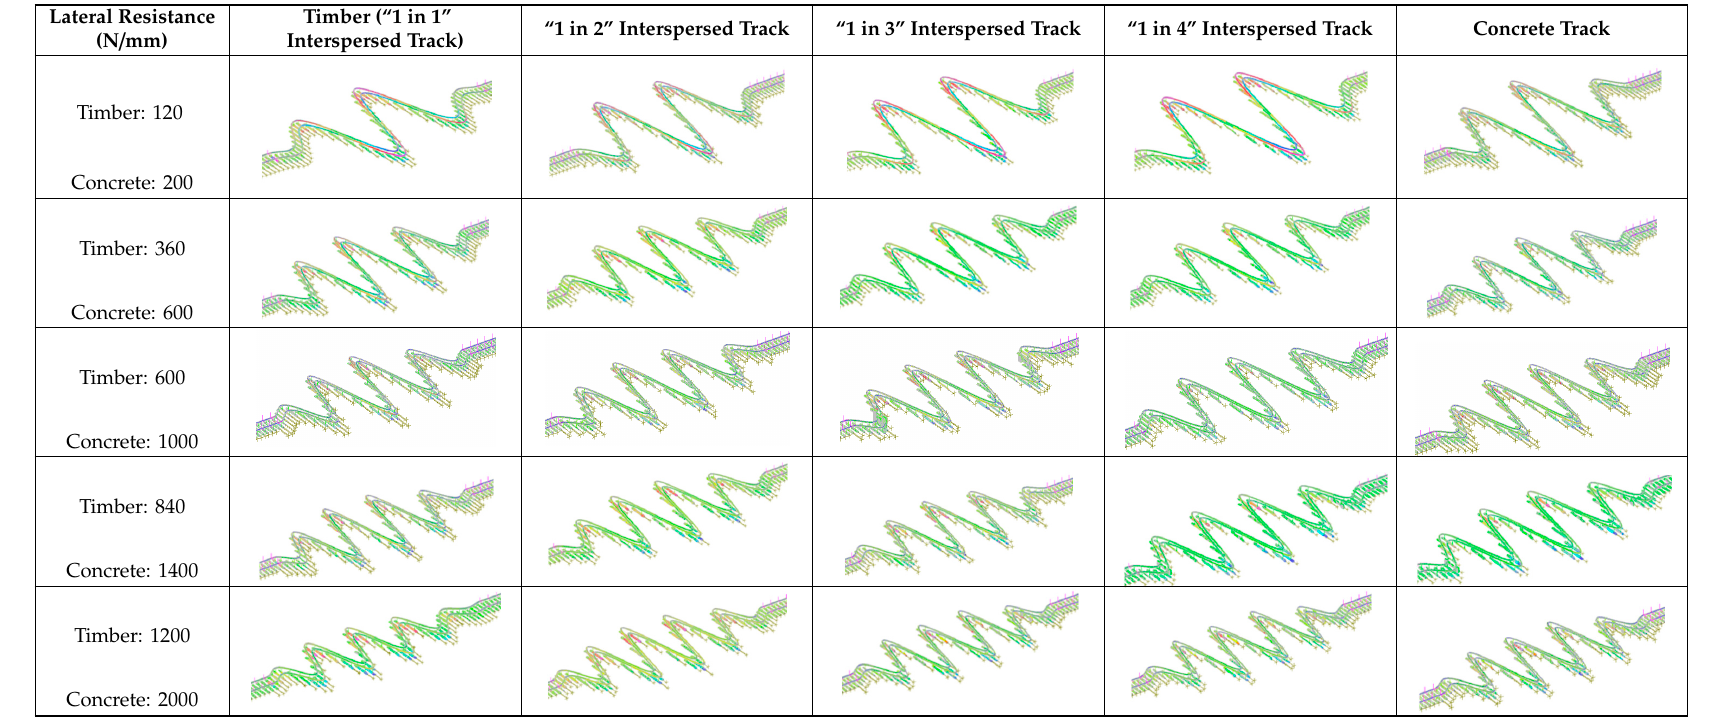
Table 3. Buckling shapes.